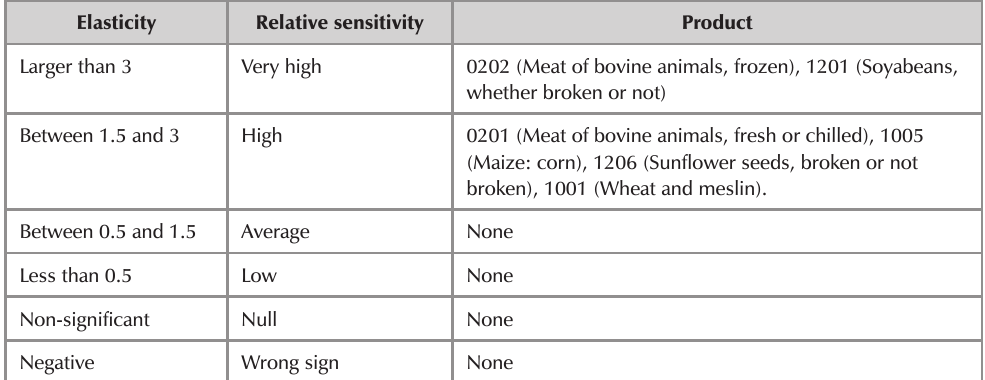
Classification of Armington elasticities (Long-run